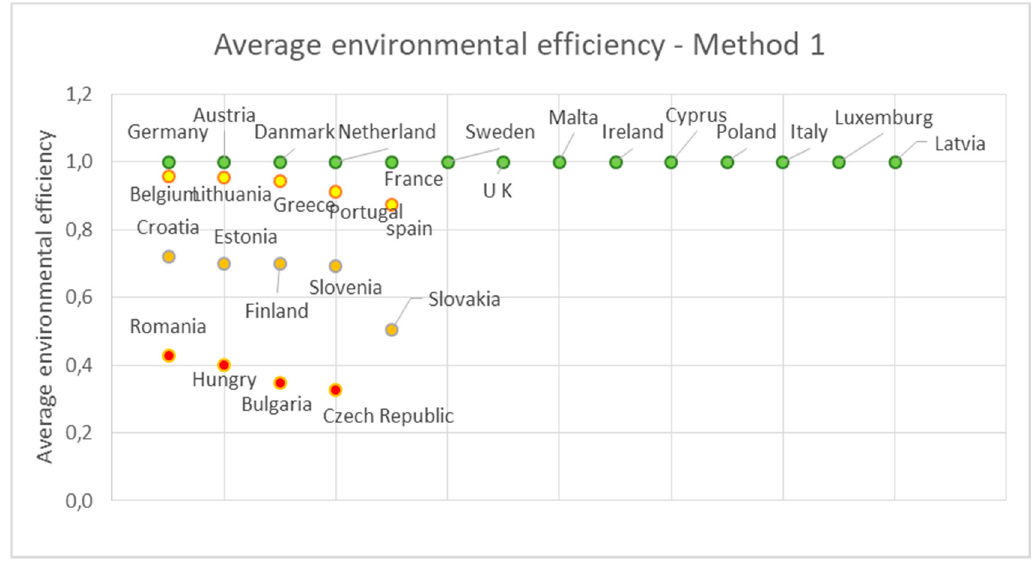
Figure 1. Average environmental efficiency of the 28 countries obtained with the DEA Method 1 classified by categories. Source: self